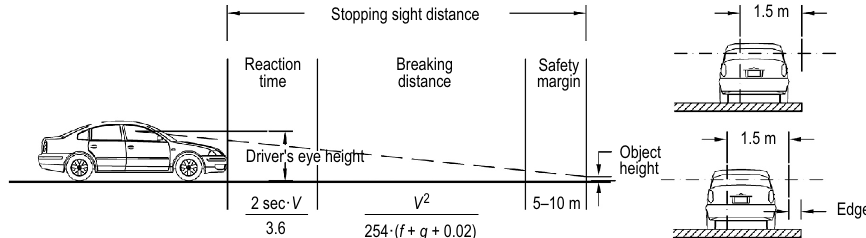
Fig. 1. Calculating